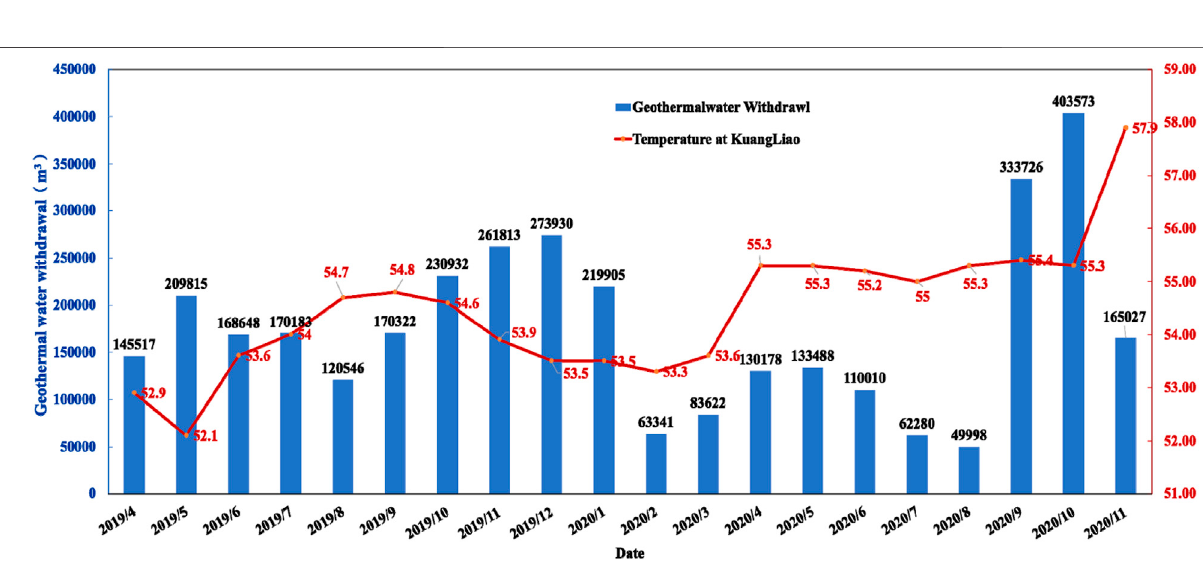
Frontiers in Earth Science |